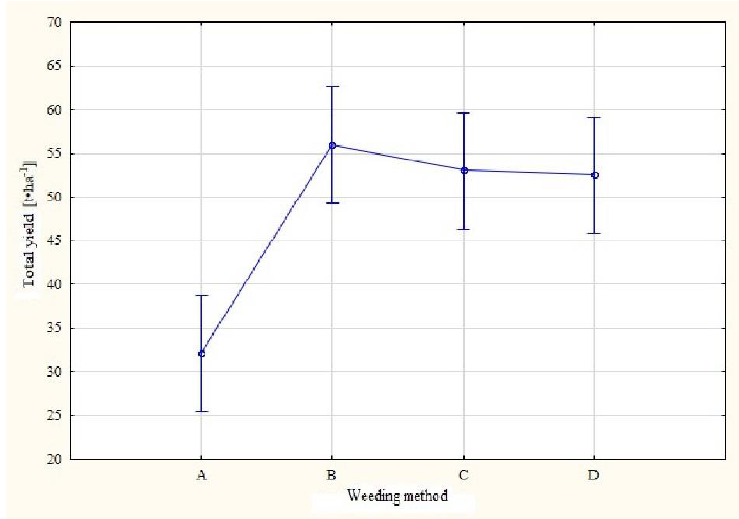
Figure 12. Expected marginal averages for 0.95 confidence intervals in total onion yield in 2018 (source: own work).